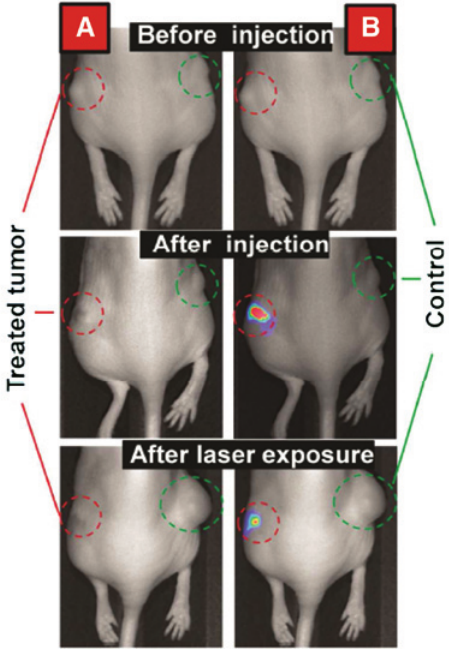
Figure 2: In vivo imaging and combinatorial phototherapy studies of SiNc-NP. Representative light (A) and fluorescence (B) images of tumor- bearing mouse before injection with SiNc-NP (top images), after injection (middle), and 25 days after treatment (bottom) with the laser diode (785 nm, 1.3 W/cm 2 , 10 min). The left tumor was injected with SiNc-NP and exposed to the laser diode. The untreated right tumor was used a control. Reproduced from Ref. (45) with permission from the Royal Society of